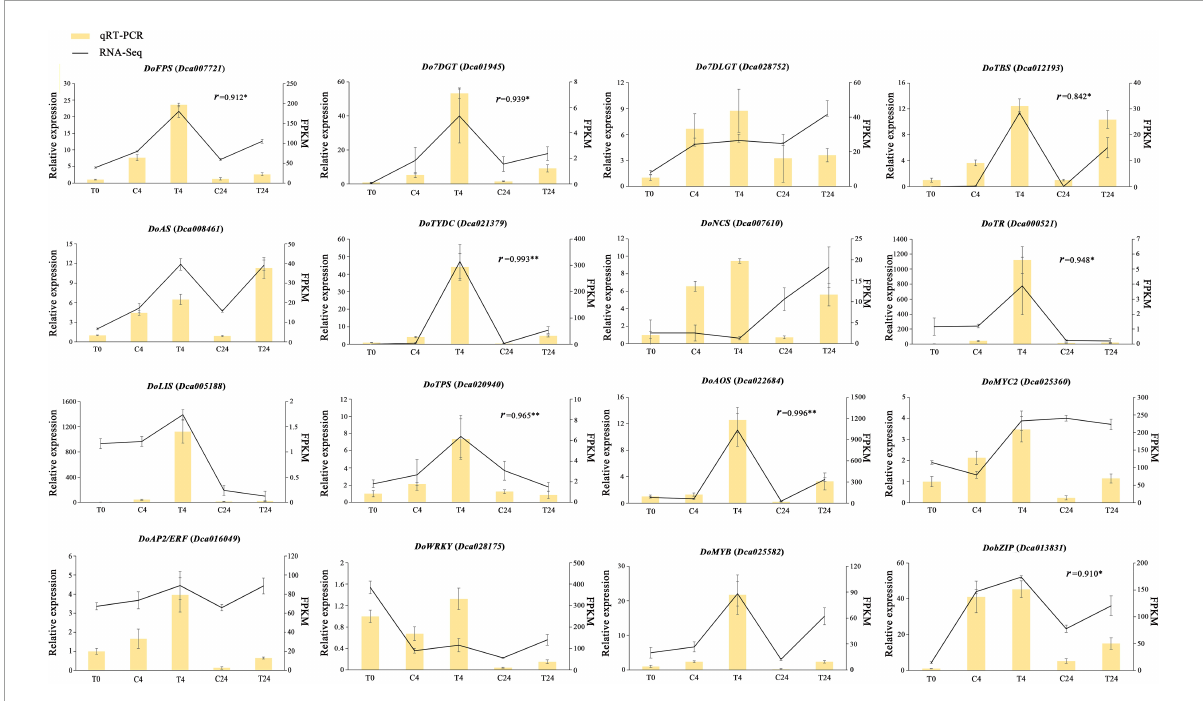
FIGURE10 qRT-PCR validation of DEGs related to alkaloid biosynthesis and metabolic regulation in D. officinale PLBs. The left y -axis represents the relative expression levels corresponding to the histogram. The right y -axis represents expression levels calculated by the FPKM method corresponding to the line plots. The relationship between the RNA-Seq and qRT-PCR in T0, C4, T4, C24, and T24 samples was analyzed based on Pearson’s correlation analysis and r represents correlation coefficients. ∗ p < 0.05, ∗∗ p < 0.01.